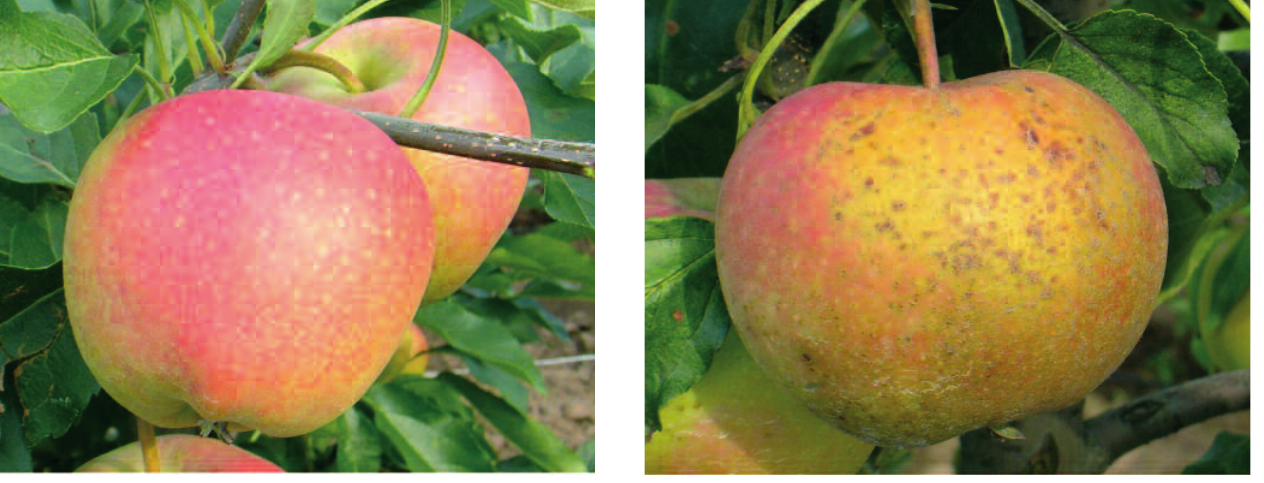
Figure 1. Integrated apples Figure 2. Organic